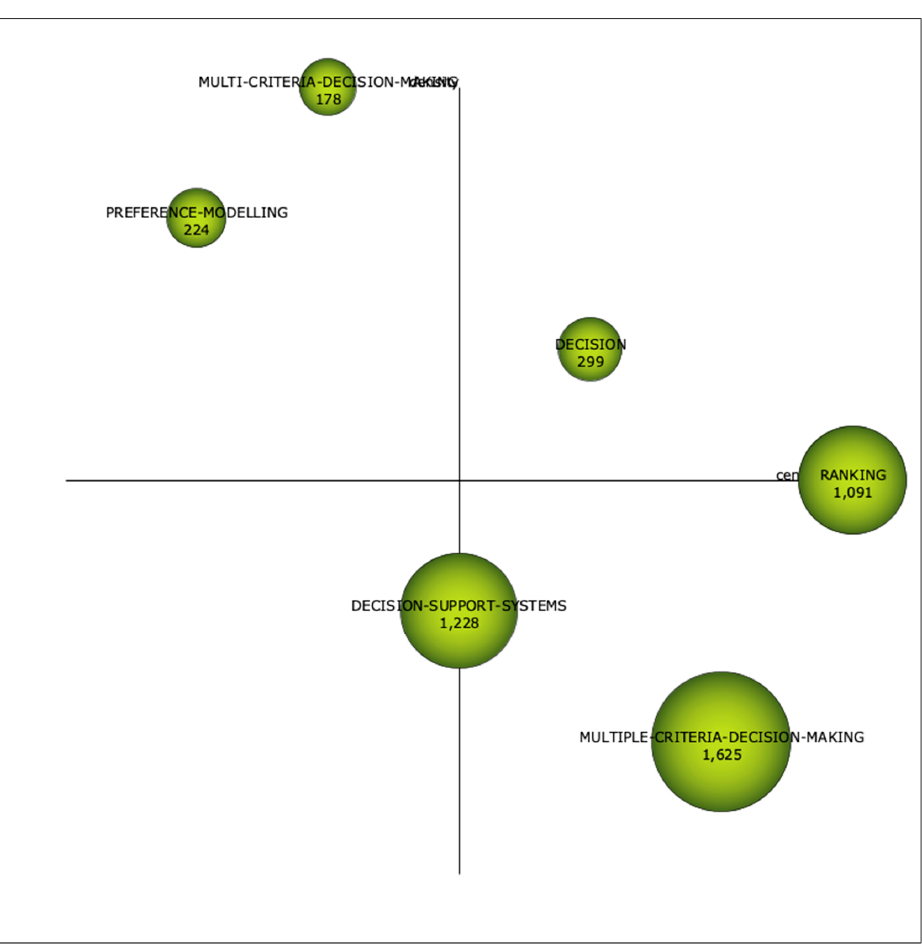
Figure 8. Strategic diagram of subperiod 1 (1979–2008). Table 6. Clusters information. Subperiod 2 (2009–2022).